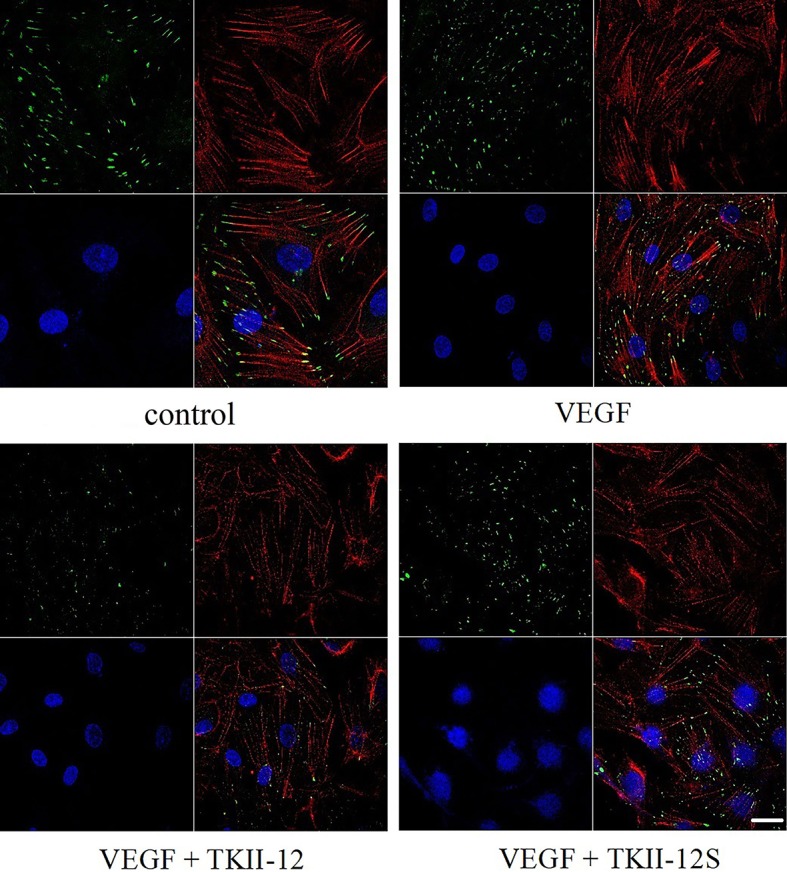
Effects of TKII-12 on vascular endothelial growth factor (VEGF)-induced formation of actin stress fibers and focal adhesion complexes in HRMECs. HRMECs were immunostained with an antivinculin antibody and stained with TRITC-conjugated phalloidin and DAPI. The scale bar is 20 μm.